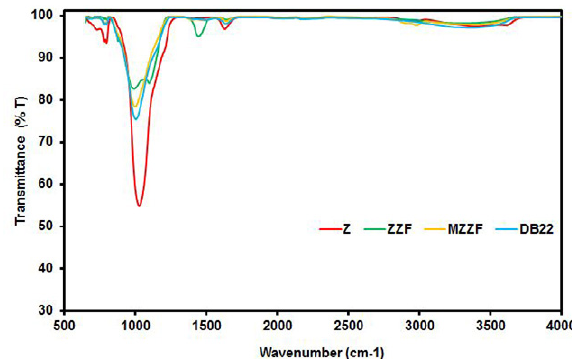
Fig. 3. FTIR analysis of the Z, ZZF, m-ZZF and m-ZZF after being used in DB-22